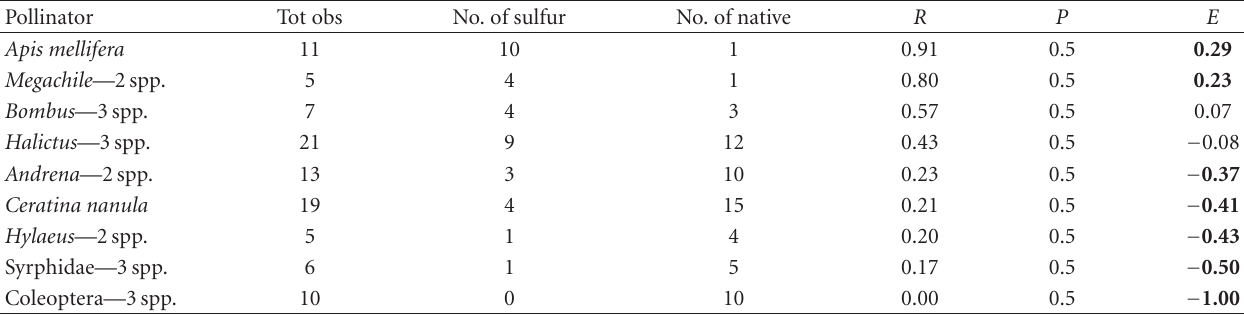
Table 4: Electivity indices for pollinator taxa under conditions of equal flower abundance. R : proportion of total pollinator population visiting plant sulfur cinquefoil; P : proportion of sulfur flowers among all cinquefoil flowers; E : electivity index = ( R sulfur − P sulfur )/( R sulfur + P sulfur